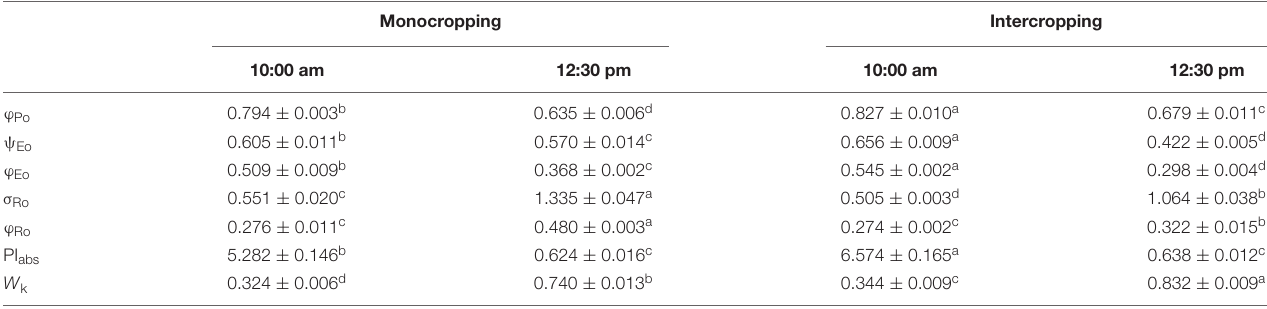
TABLE 5 | Selected parameters derived from fast fluorescence kinetic measurements in soybean leaves at 10:00 am and 12:30 pm (the PAR of soybean leaf under intercropping and monocropping were 1213 and 1411 µ mol m − 2 s − 1 at 10:00 am, while the PAR of soybean leaf under intercropping and monocropping were 1750 and 1860 µ mol m − 2 s − 1 at 12:30 pm).